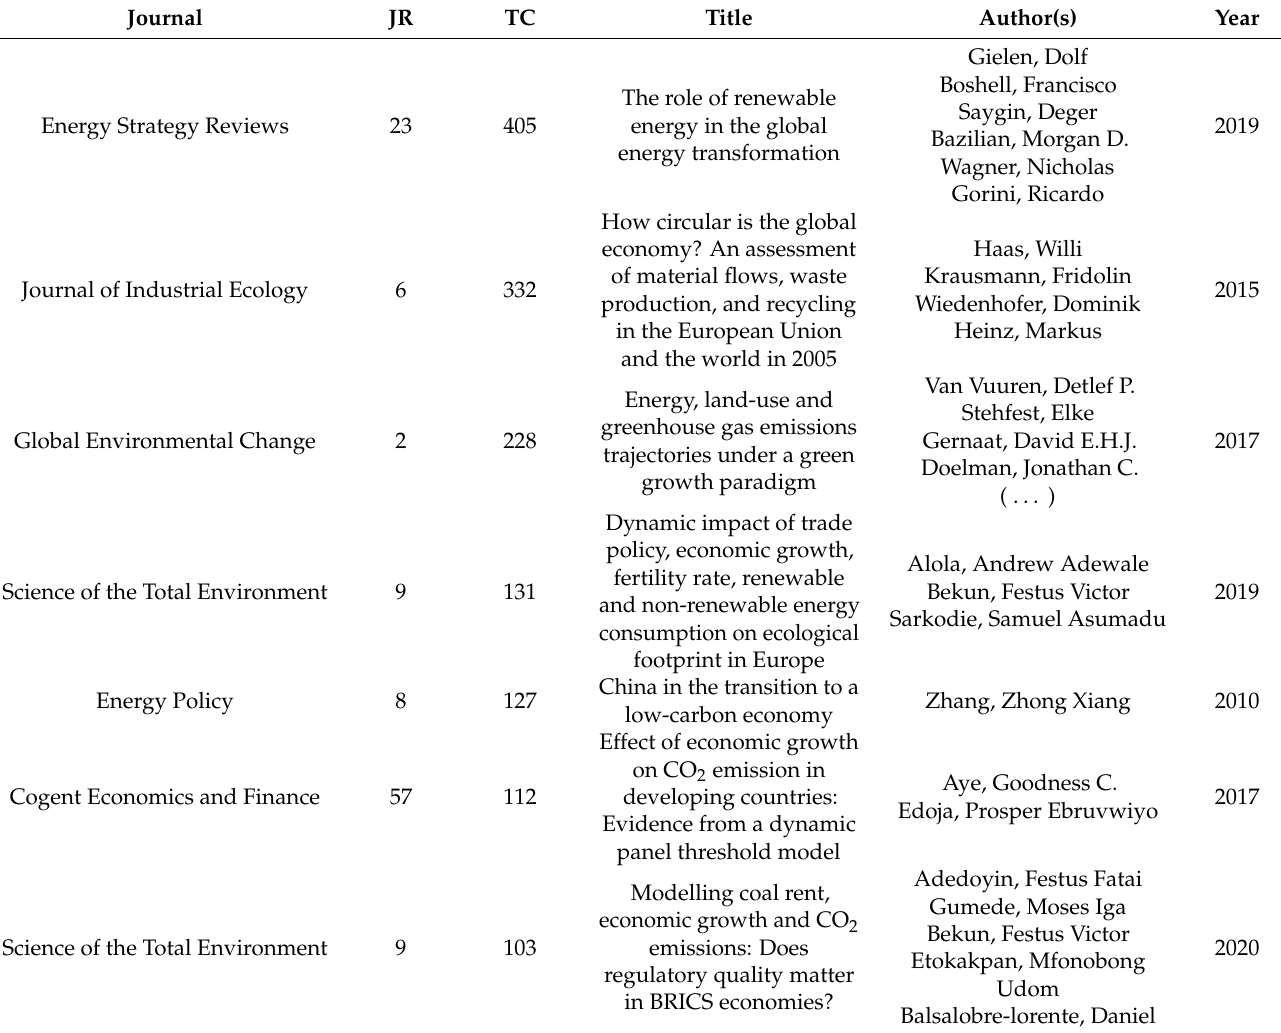
Table 3. Most Cited Articles in the Period